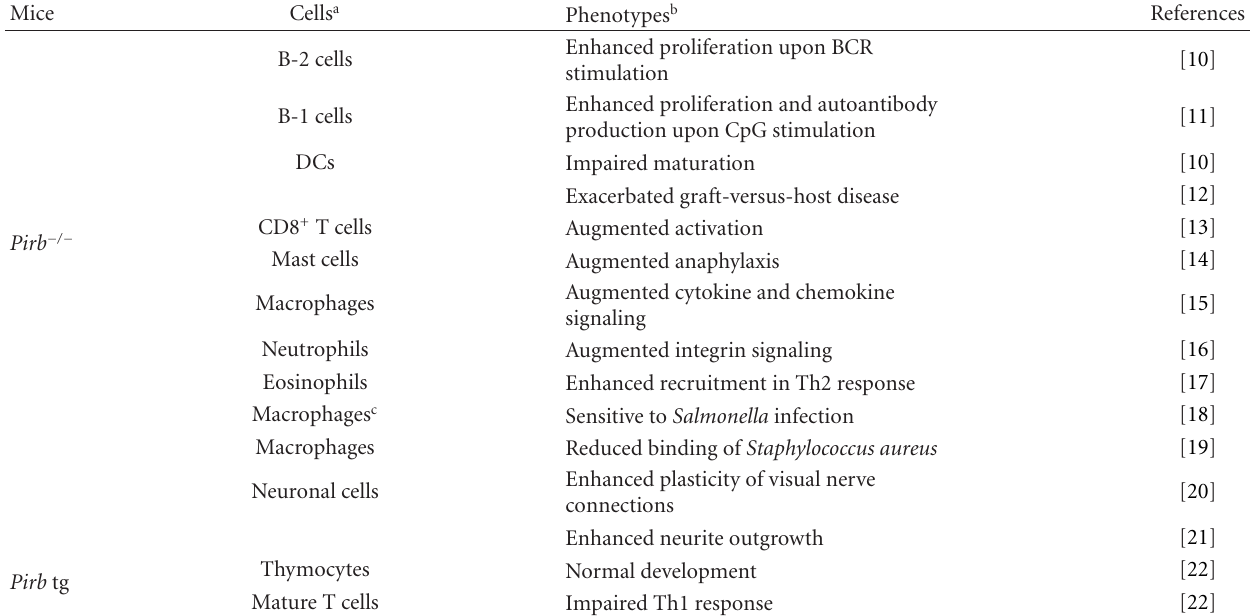
Table 1: Phenotypes observed in Pirb − / − mice and Pirb transgenic (tg) mice.